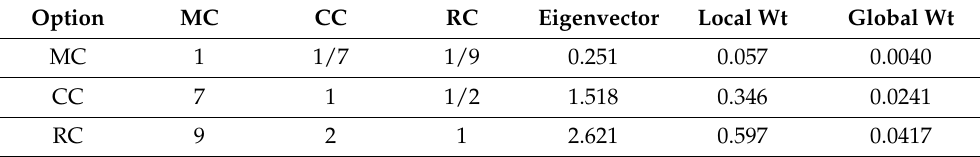
Table A16. Comparison of alternatives matrix for subcriterion PE3.